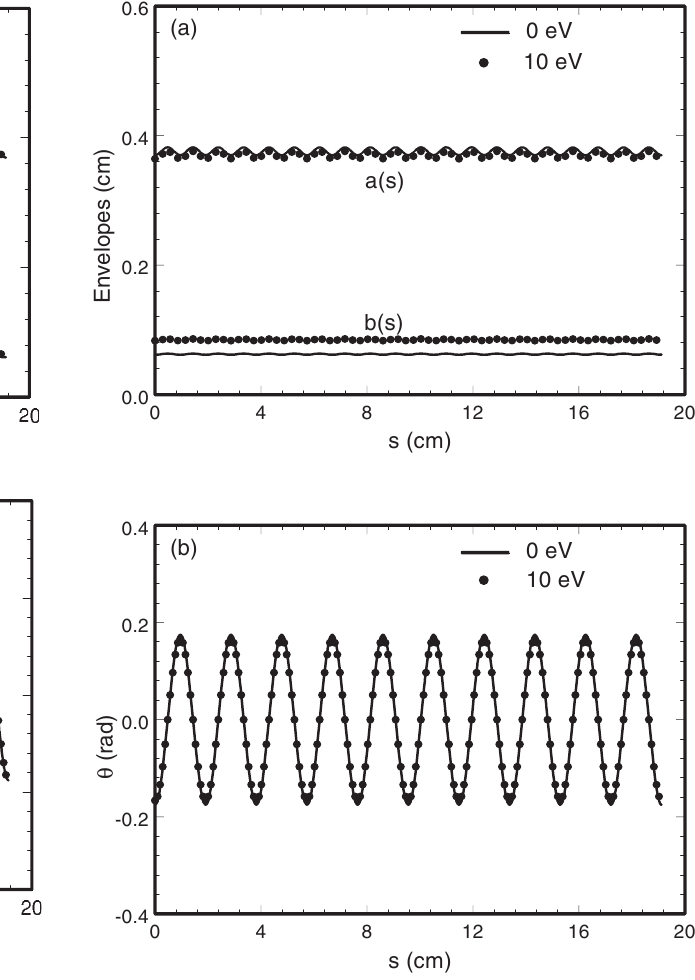
FIG. 2. Plots of (a) envelopes a (cid:3) s (cid:4) and b (cid:3) s (cid:4) and (b) twist angle (cid:3) (cid:3) s (cid:4) versus the axial distance s for the nonrelativistic twisted elliptic beam. The solid curves are the generalized envelope solution for a zero-temperature beam, whereas the dotted curves are for a 1 eV on-axis temperature beam.